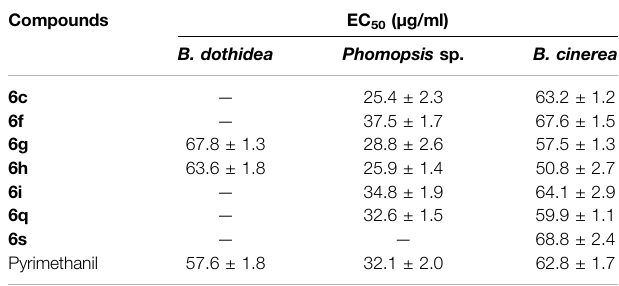
TABLE 2 | EC 50 values of the title compounds against B. dothidea , Phomopsis sp., and B. cinereal .